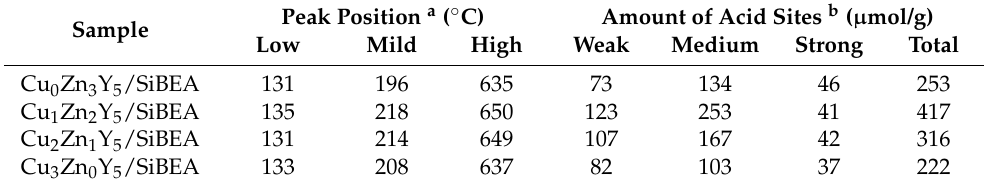
Table 2. The acidity of the fresh CuZnY/SiBEA catalysts.